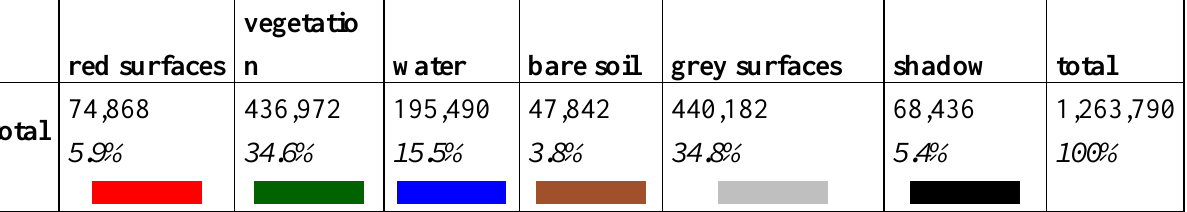
Table 1. Total number of validation pixels for each target class, relative weight of each class in the validation set, and colour used for representing each class in the